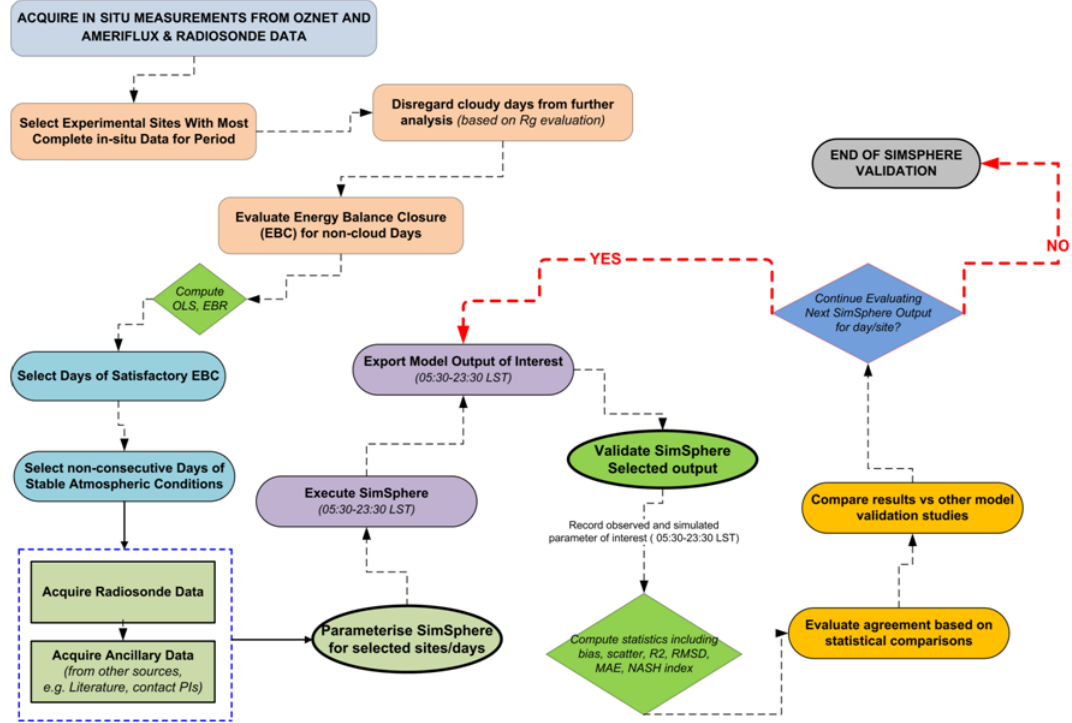
Figure 1. Flowchart of the overall methodology followed in evaluating SimSphere’s